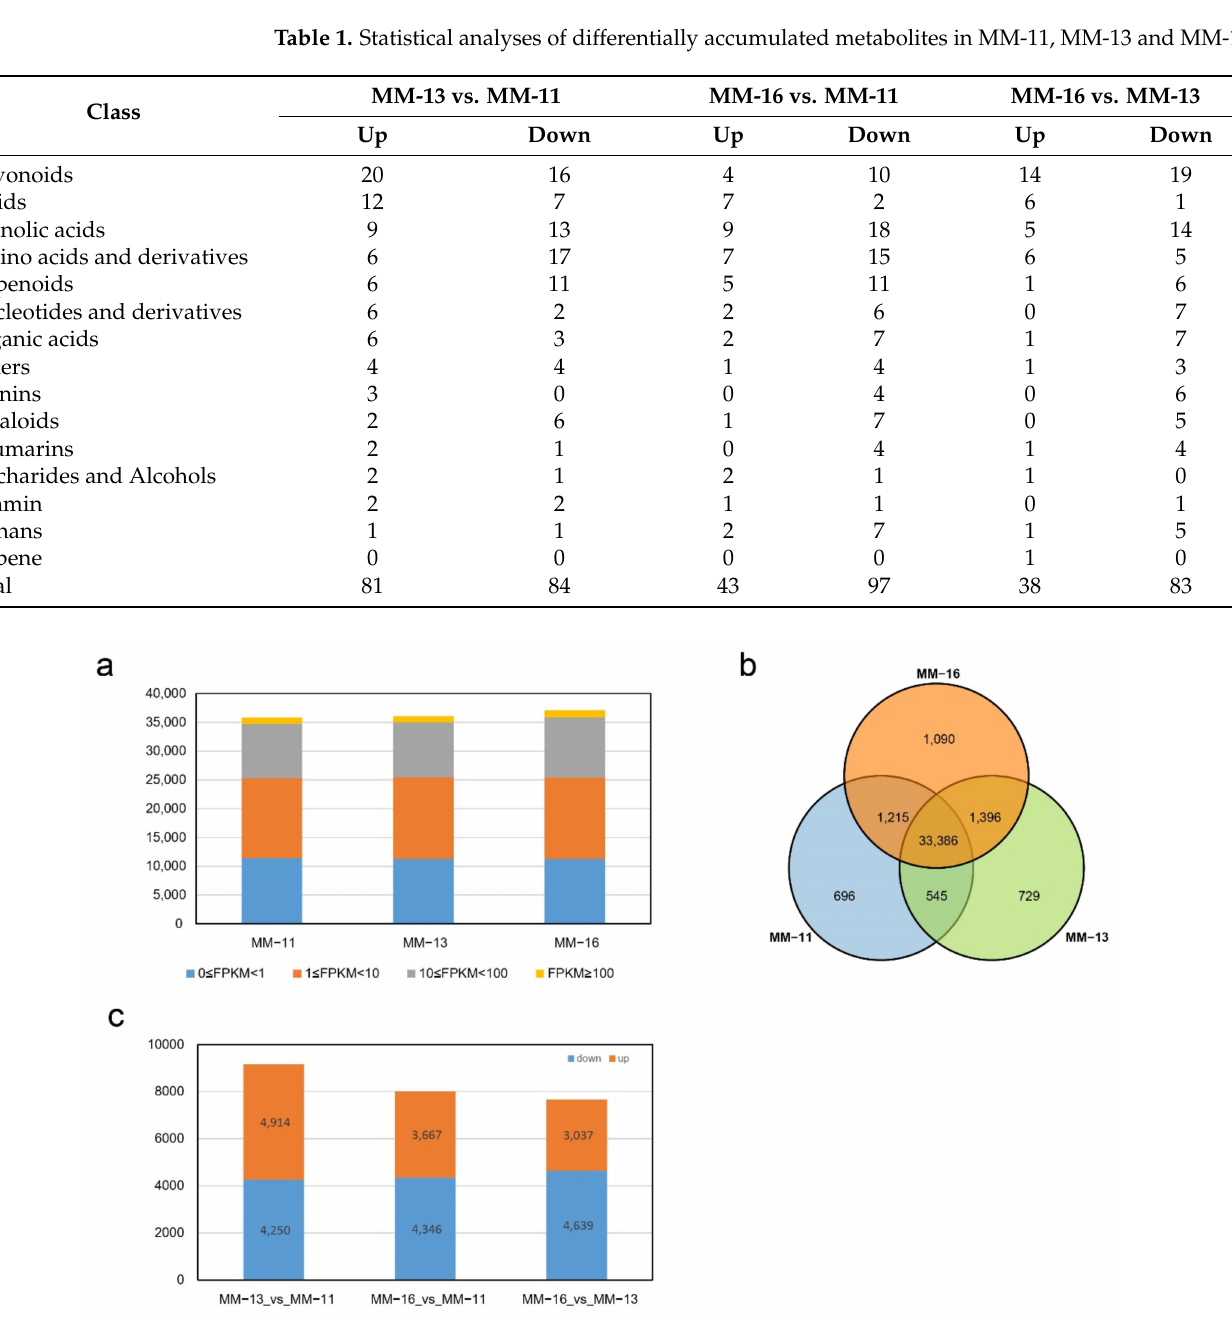
Figure 4. F Overview of kiwifruit MM-11, MM-13 and MM-16 fruit transcriptomes. ( a ) Distribution of genes with high expression (FPKM ≥ 100), middle expression (100 > FPKM ≥ 10), low expression (10 > FPKM ≥ 1), and no expression (1 > FPKM ≥ 0). ( b ) Venn diagram of genes expressed in MM-11, MM-13 and MM-16 samples. ( c ), Distribution of up- and down-regulated DEGs in the pair-wise MM-13 vs. MM-11, MM-16 vs. MM-11 and MM-16 vs. MM-11